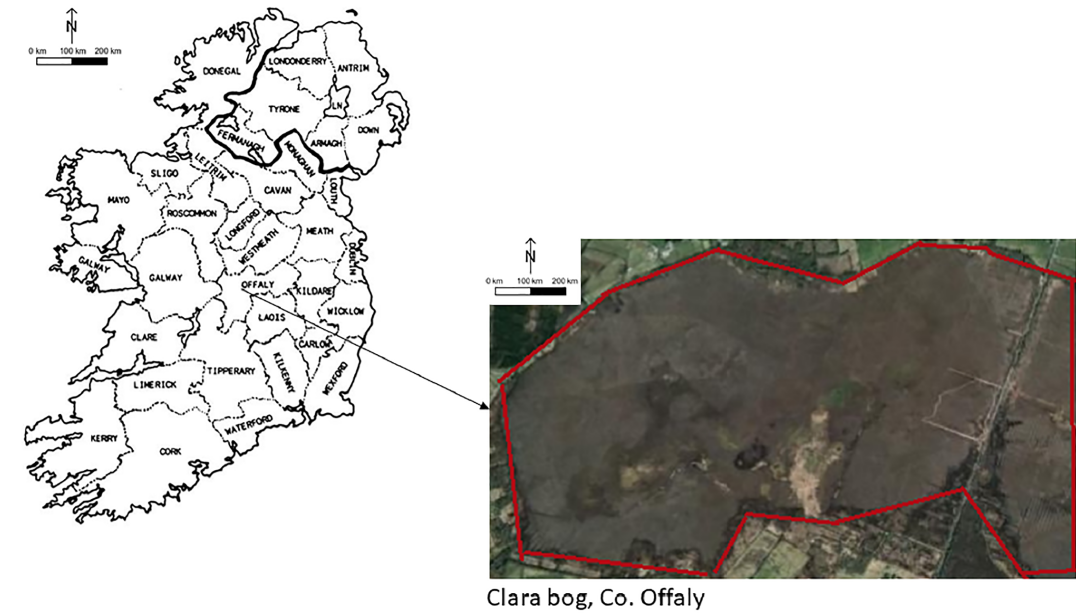
Figure 1. Clara Bog, Co.